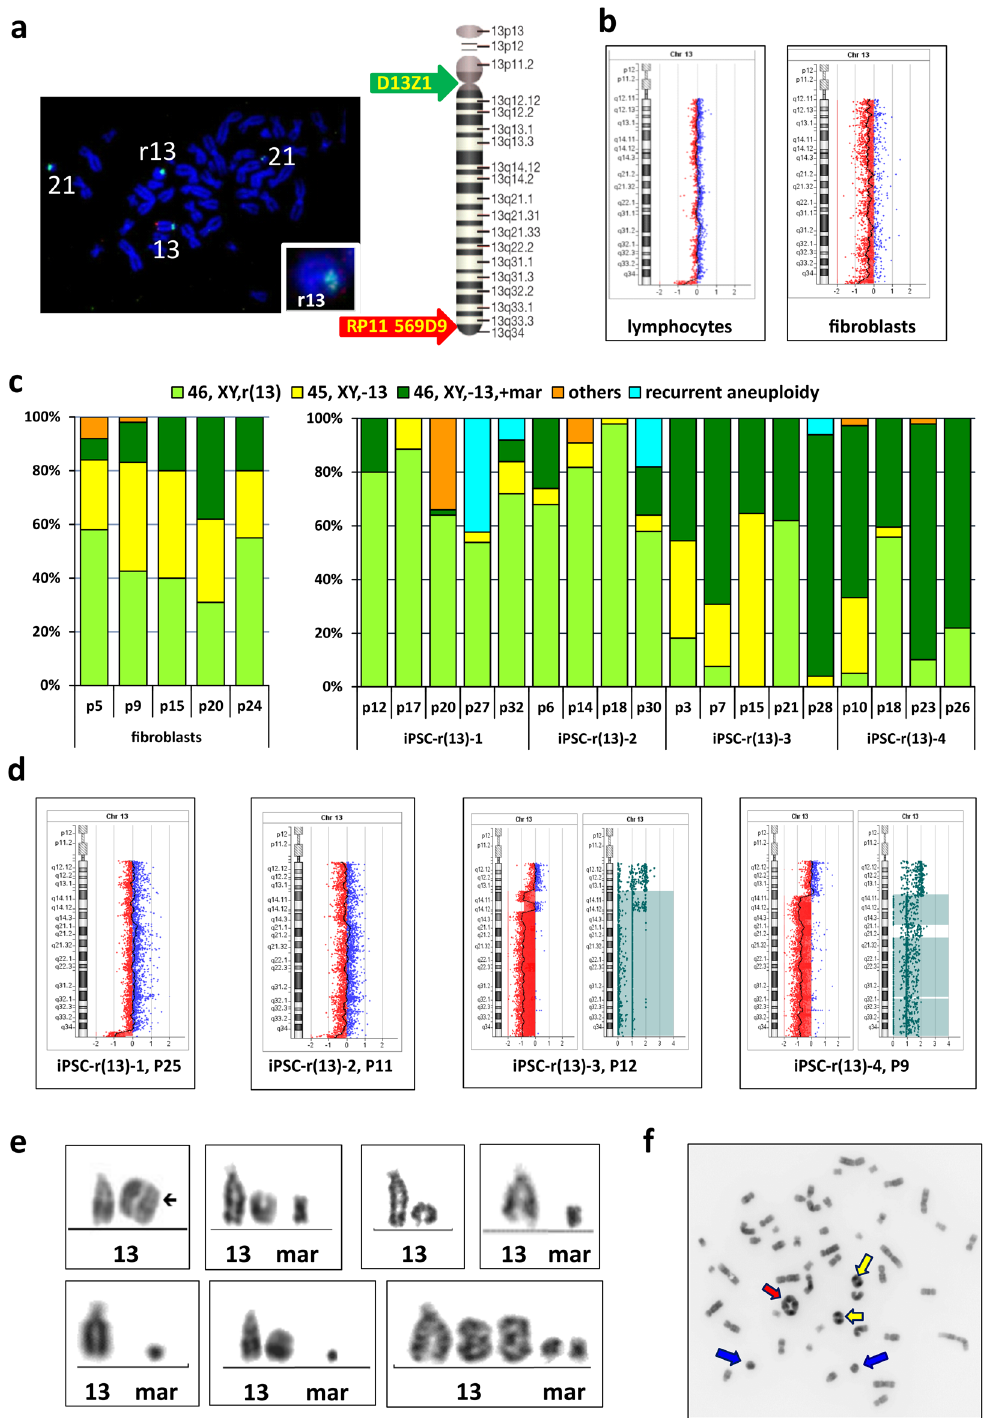
Figure 2. Results of GTG and molecular karyotyping of cell lines with r(13). ( a ) FISH analysis showing r(13) morphology (green: centromeric 13/21 probe D13Z1; red: probe RP11-569D9 on the distal part of the long arm of chromosome 13 (13q34), located in the deleted region) [ISIS software (v.5.5), MetaSystems (https ://metas ystem s-inter natio nal.com/en/produ cts/isis/)]. ( b ) aCGH profiles of chromosome 13 in lymphocytes (left) showing two deletions at 13q34 and fibroblasts (right) with signs of monosomy 13 [CytoGenomics (v. 3.0.6.6) (https ://www.agile nt.com/en/downl oad-agile nt-cytog enomi cs-softw are)]. ( c ) Karyotype rates in fibroblasts (left) and iPSC lines (right) at different passages. ( d ) aCGH profiles of iPSC lines demonstrating iPSC-r(13)-1 at P25 with amplification of 13q31.3 (26 kb) and a terminal 13q34 deletion (2.53 Mb); iPSC-r(13)-2 at P11 with a 13q34 terminal deletion (1.987 Mb); iPSC-r(13)-3 at P12 with 5 large deletions covering most of the long arm and the normal copy region of 5.333 Mb surrounded by deleted regions within the LOH region of 80.116 Mb; and iPSC-r(13)-4 at P9 with multiple deletions on chromosome 13 and three LOH regions of 16.692 Mb, 32.472 Mb and 20.627 Mb, respectively [CytoGenomics (v. 3.0.6.6) (https ://www.agile nt.com/en/downl oad-agile nt-cytog enomi cs-softw are)]. ( e ) Examples of chromosome 13 pairs in fibroblasts and iPSCs with r(13) or derivative marker chromosomes. ( f ) Example of metaphase spread with amplification of r(13); red arrow: tetracentric ring, yellow arrows: dicentric rings, blue arrows: monocentric